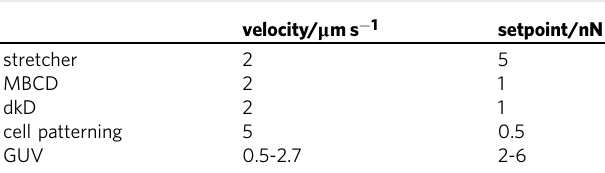
Table 1 Parameters used for the AFM indentation experiments 13,29,30,35